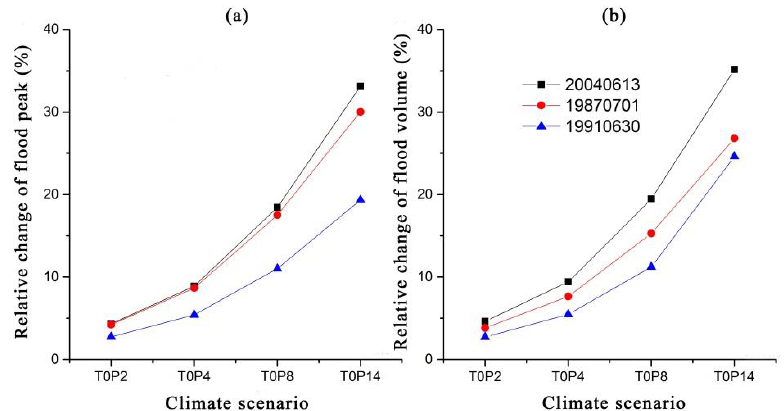
Figure 2. The hydrological response of precipitation changes for different-scaled floods: ( a ) Relative change of flood peak under precipitation changes; ( b ) Relative change of flood volume under precipitation changes.